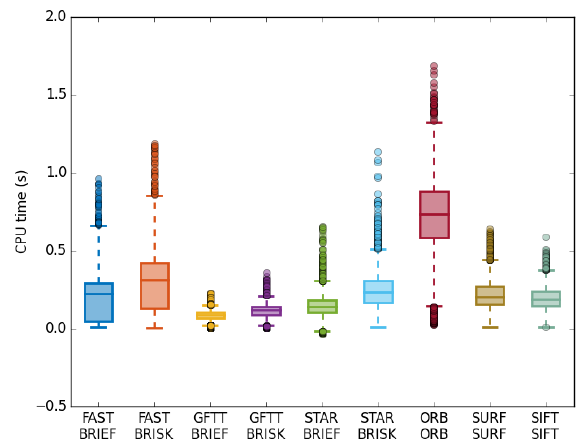
Figure 3. Tracking time without taking into account feature extraction